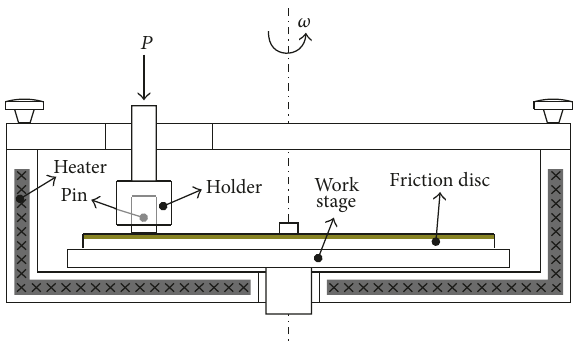
Figure 2: Elevated temperature chamber for rotary